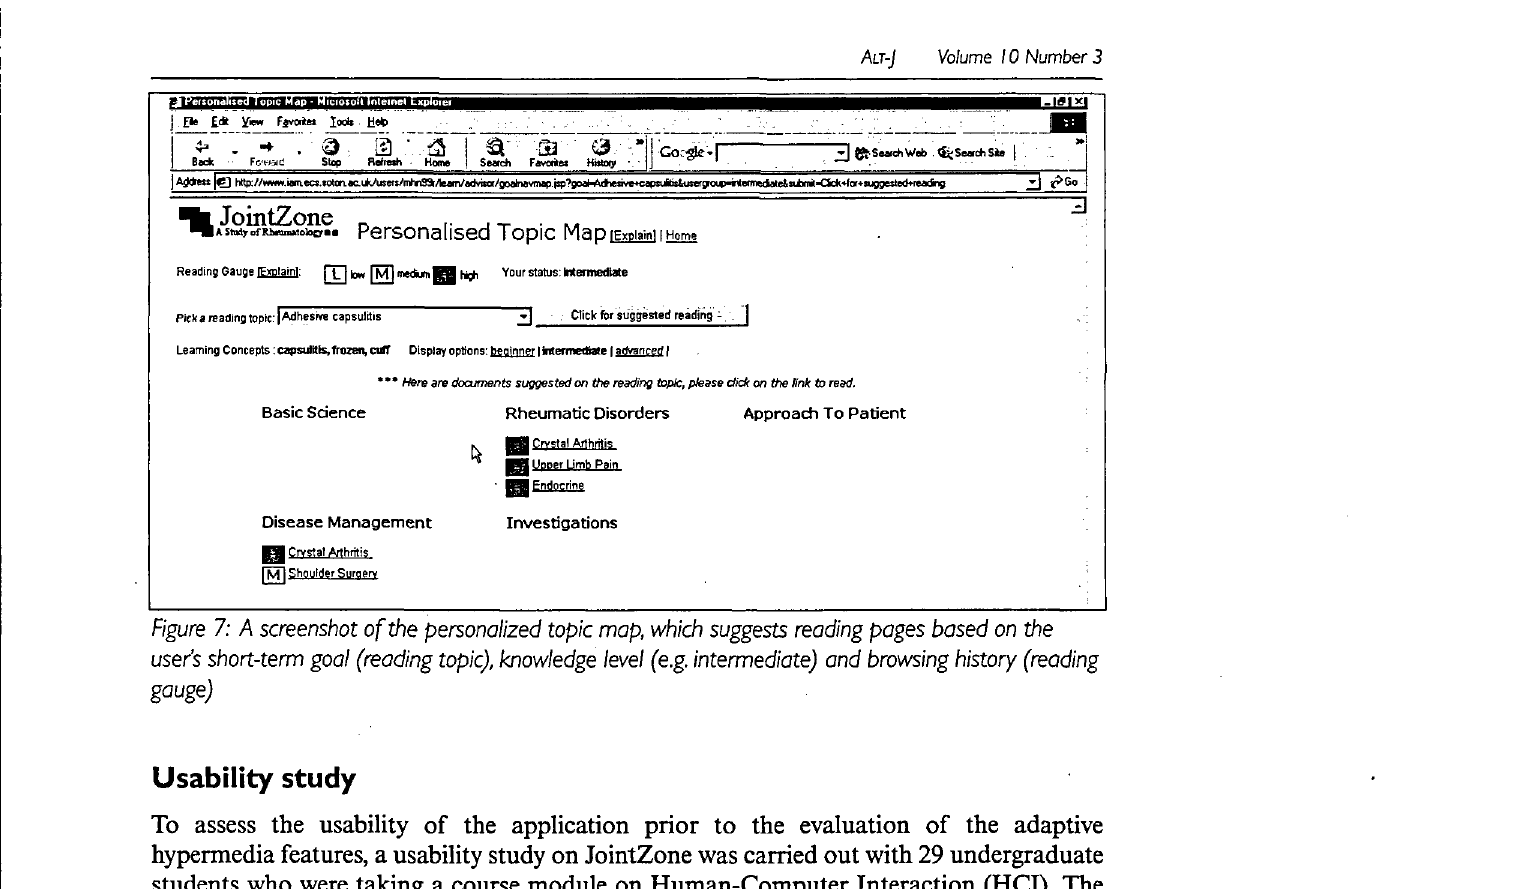
Figure 7: A screenshot of the personalized topic map, which suggests reading pages based on the user's short-term goal (reading topic), knowledge level (e.g. intermediate) and browsing history (reading